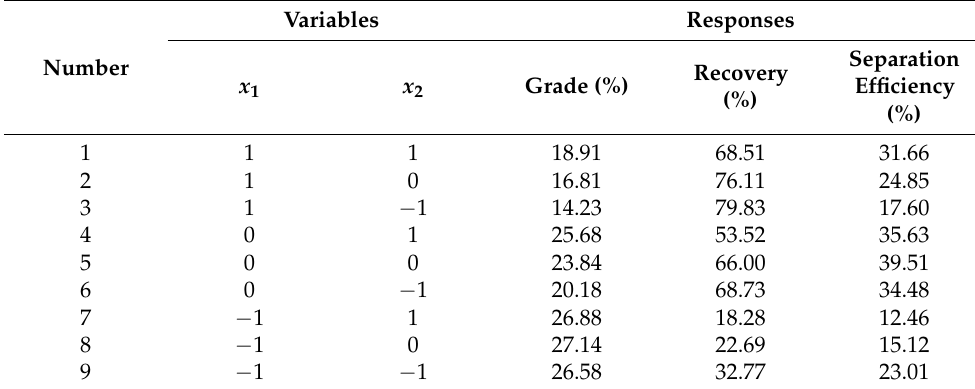
Table 5. Two-factor three-level orthogonal test